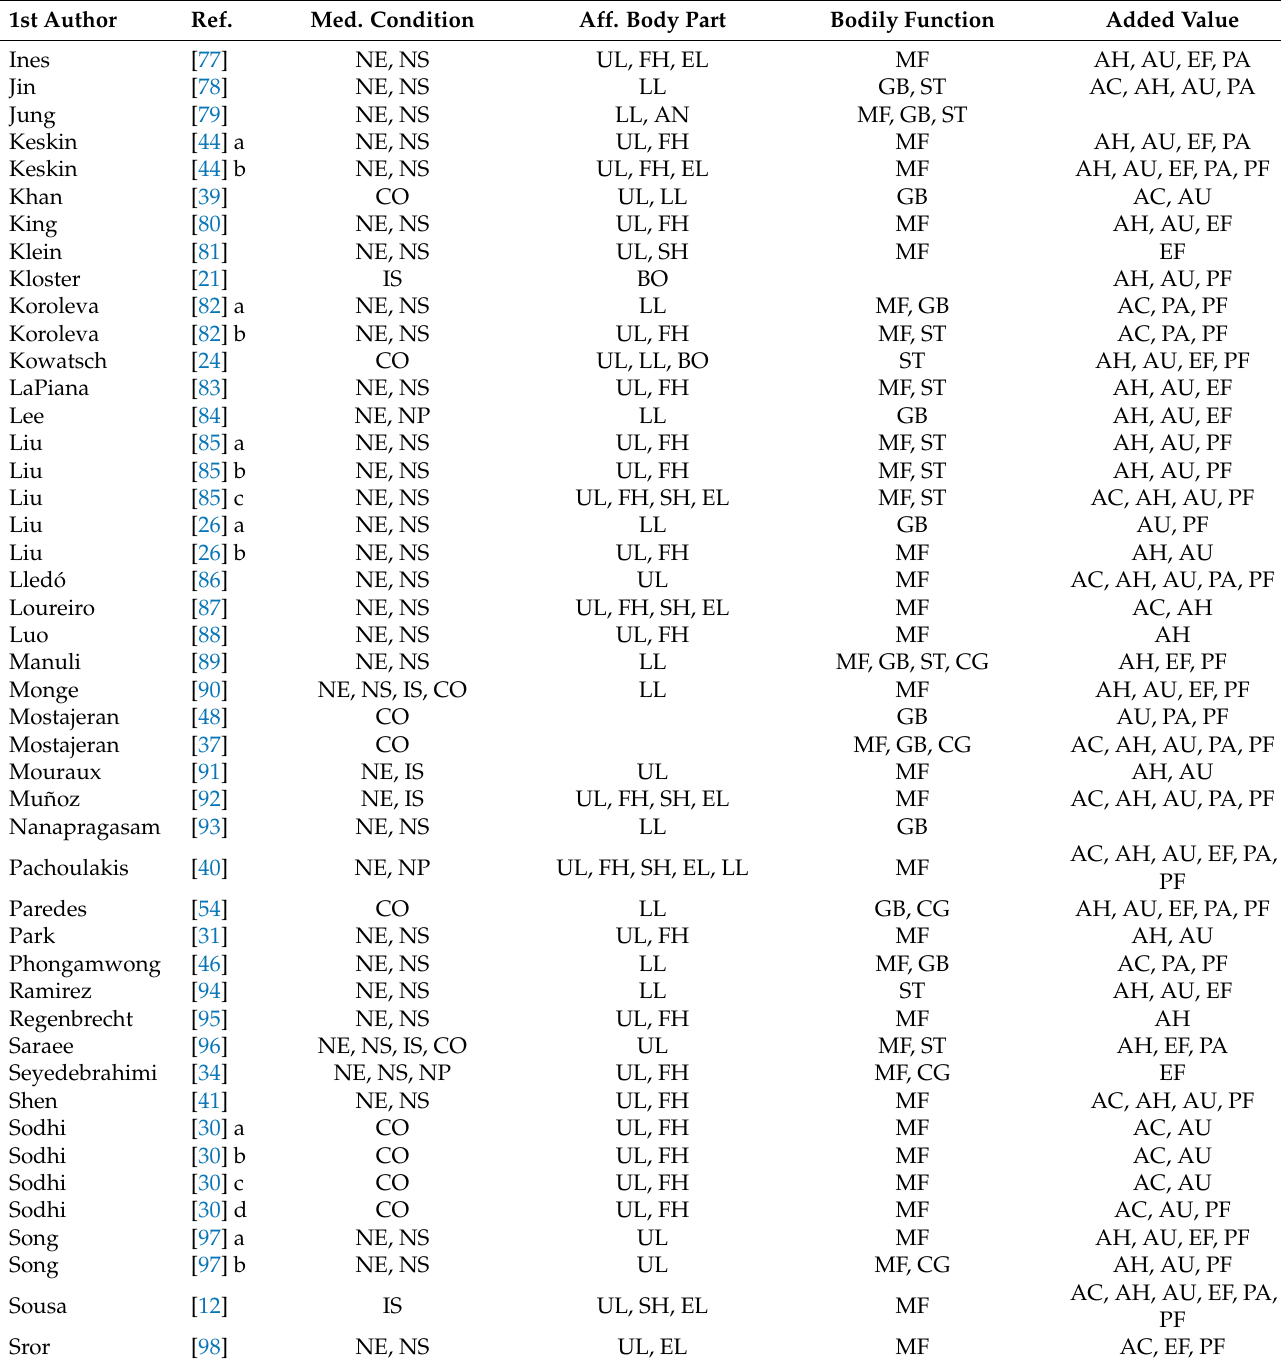
Table A3. Overview of the selected references—author names I–Sr, part 1/2, Abbr. in Table A7. Distinct applications within a reference are marked with lowercase